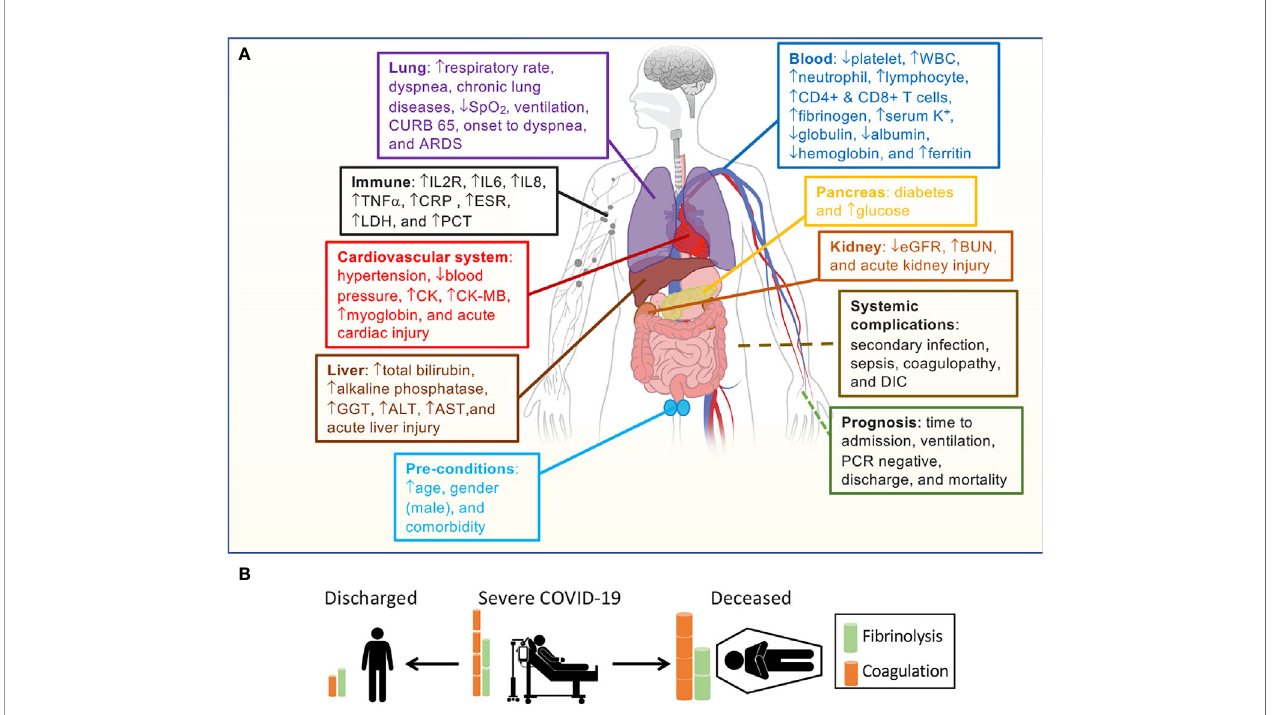
FIGURE 4 | Correlation of D-dimer elevations and aberrant fi brin deposition with organ dysfunction. (A) D-dimer-associated clinical parameters sorted by the system and clinical relevance. (B) Outcomes correlate with D-dimer levels based on our